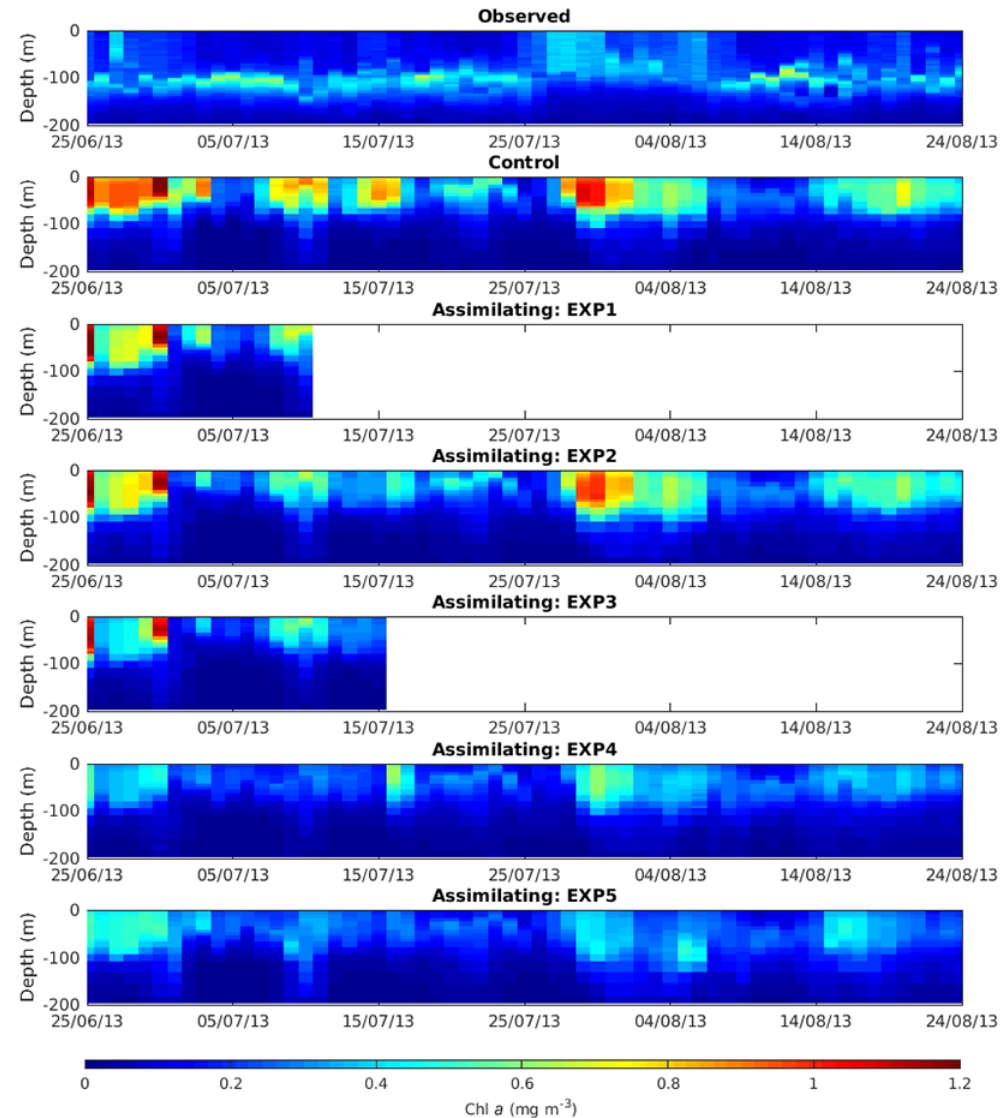
Figure 7. Comparison against independent IMOS glider observations, with the observed section of Chl a derived from the onboard fluores- cence sensor. The comparison is undertaken in model space, whereby all glider data that fall within a 1h window either side of when there is a 3-D model output available are extracted, and equivalent simulated Chl a are extracted from the model. The glider and model data are then spatially aggregated and interpolated onto the vertical model grid. The resulting observed (top) and simulated (control and assimilation experiments) sections for the IMOS glider are